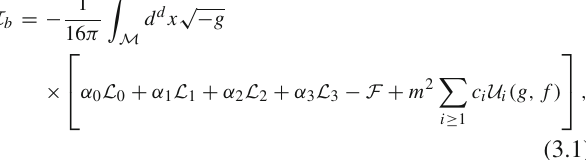
Fig. 4 RN-AdS black hole: P − r + (left), T − r + (middle) and G − T (right) diagrams for k = 1, d = 4 and q = 1. Left panel: T < T c (continuous lines), T = T c (dotted line) and T > T c (dashed lines).